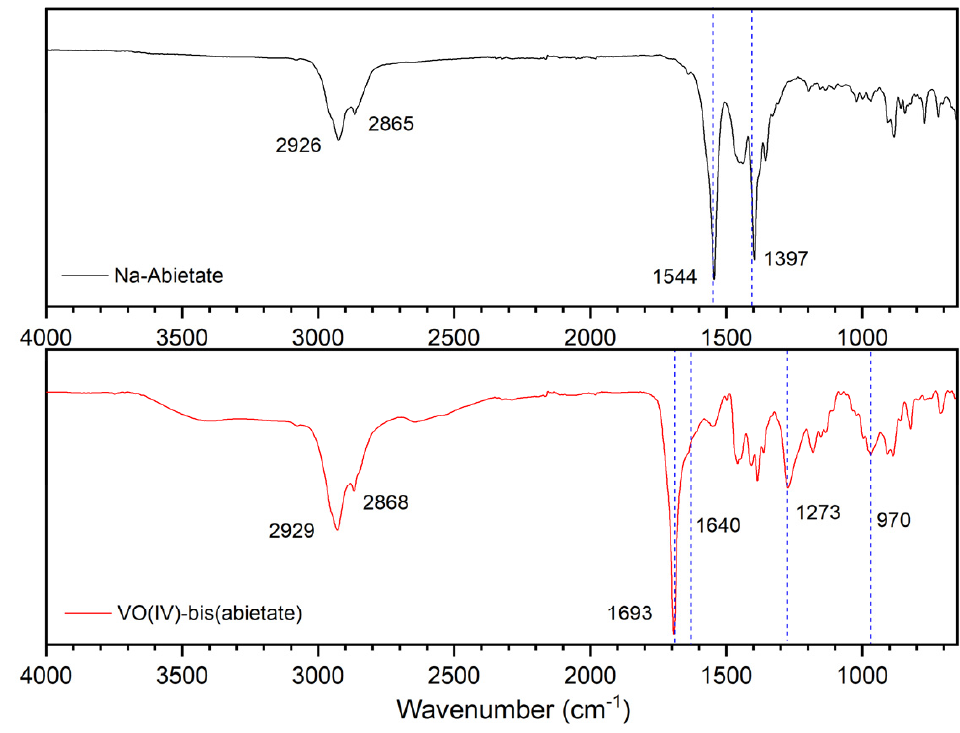
Figure 4. FTIR spectra of the Na-abietate and VO(IV)- bis (abietate). In the vibrational spectrum for VO(IV)- bis (abietate) (Figure 4b), the bands at 2929 cm − 1 and 2868 cm − 1 attributed to the C-H stretches stand out. The main bands to be highlighted are at 1693 cm − 1 and 1640 cm − 1 , attributed to the asymmetric and symmetrical stretching, respectively, of the carboxylate group present in the ligand. These bands are typical of the COO − group but may vary according to the ligand and the metallic center [1]. The characteristic peak of the V=O bond occurs around 970 cm − 1 . Peaks in the 1273 cm − 1 region may be indicative of C=O